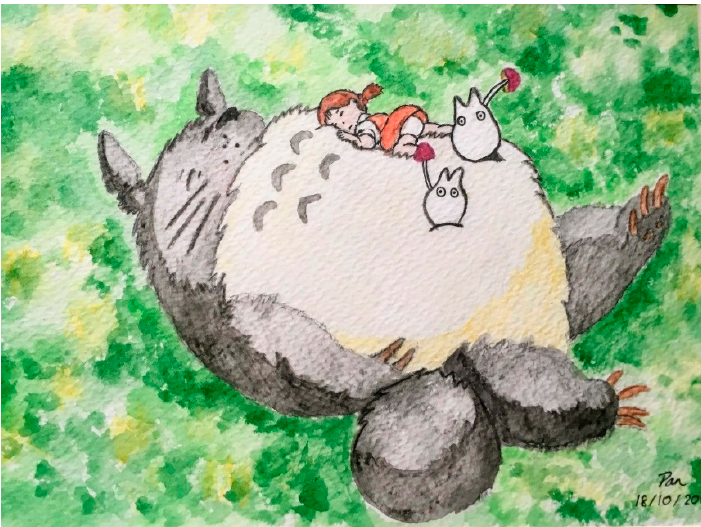
Figure 4. Totoro, a giant forest spirit, with Mei and smaller Totoros lying on top of him, as depicted in My Neighbor Totoro